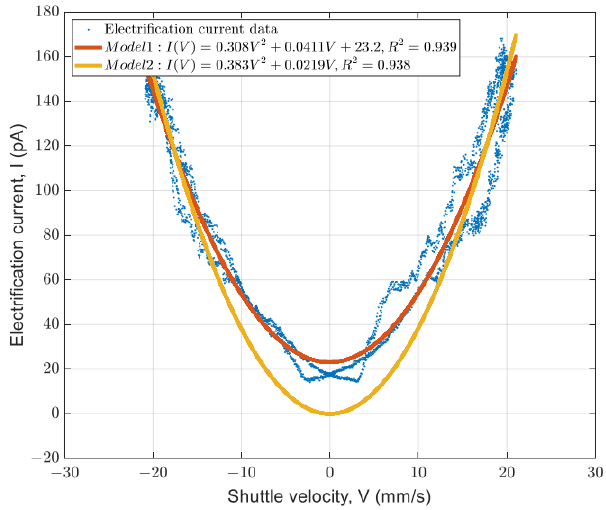
Figure 15. Dependence of electrification on intermittent shuttle speed and fitted second order polynomial models. Shuttle frequency of 0.4 Hz.